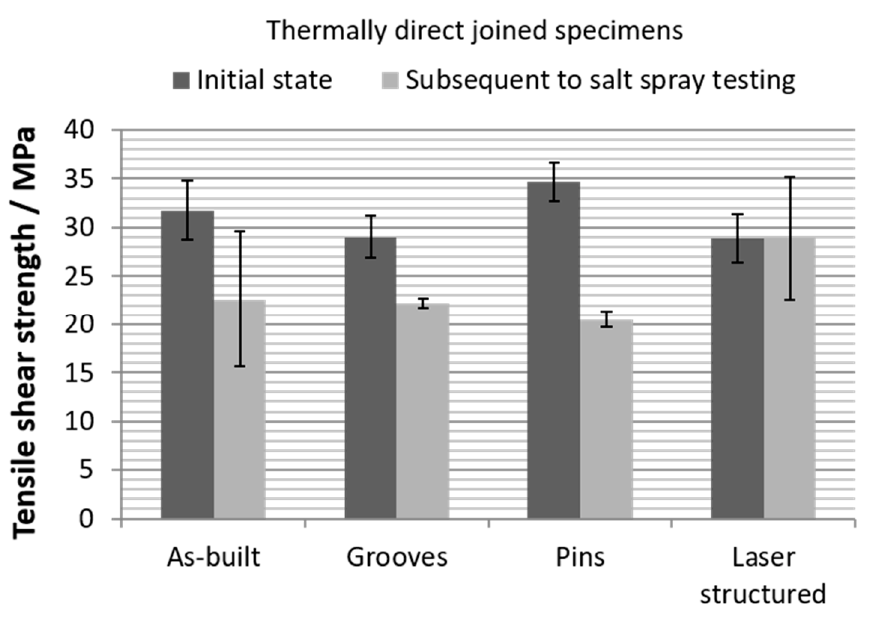
Figure 7. Tensile shear strength of thermally direct joined specimens in the initial state and after salt spray testing for 1000 h. Table 2. Overview of initial tensile shear strength and retained tensile shear strength after salt spray testing for adhesive bonded and thermally direct joined